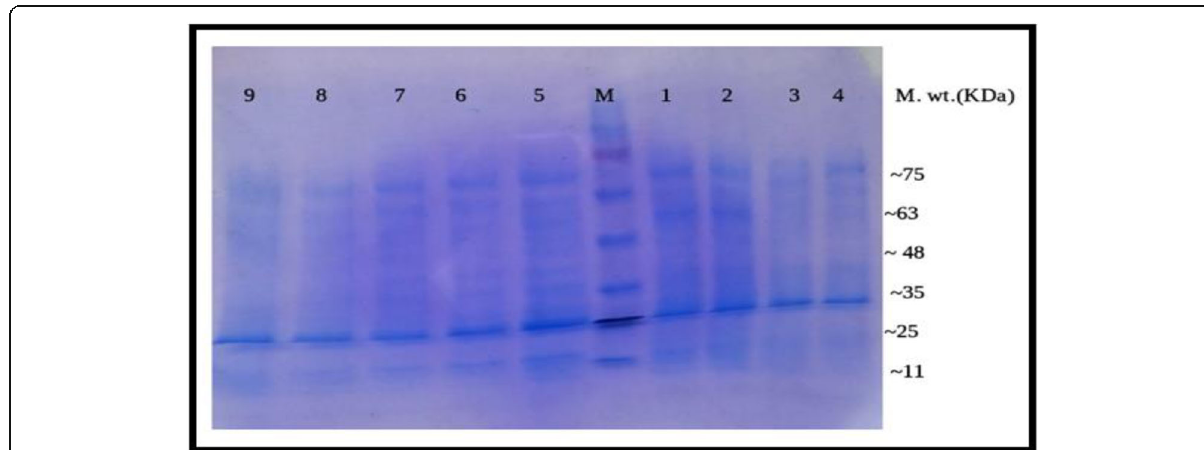
Fig. 9 SDS-Polyacrylamide gel of protein pattern of liver tissue samples. M = Marker 11 – 75 KDa, lanes 1 – 9: groups 1 – 9. Lane 1 represents the electrophoretic pattern of CCl 4 group, lane 2 represents the electrophoretic pattern of sulfamethoxazole group, lane 3 represents the electrophoretic pattern of combination (curcumin + sulfamethoxazole) group, lane 4 represents the electrophoretic pattern of curcumin group, lane 5 represents the electrophoretic pattern of the DMSO control group, lane 6 represent the electrophoretic pattern of combination (curcumin + sulfamethoxazole) control group, lane 7 represents the electrophoretic pattern of sulfamethoxazole control group, lane 8 represents the electrophoretic pattern of curcumin control group, and lane 9 represent the electrophoretic pattern of the normal control